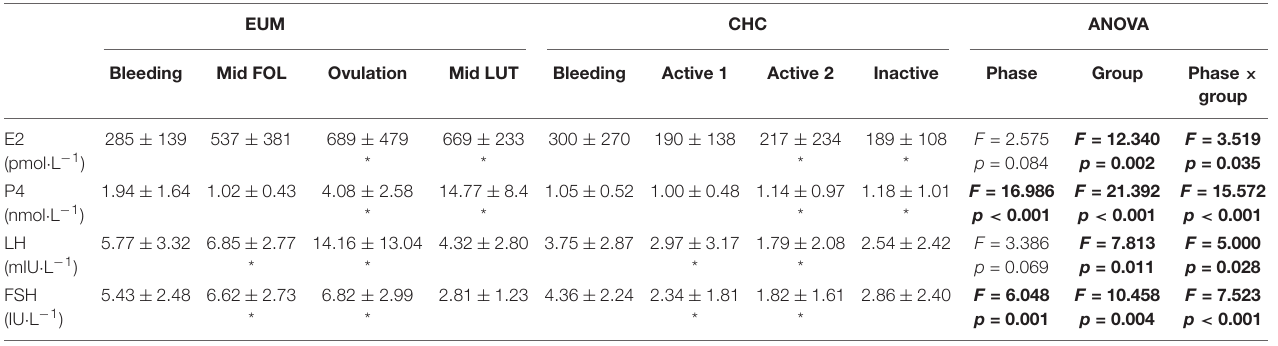
TABLE 3 | Serum concentrations of estradiol (E2), progesterone (P4), luteinizing hormone (LH), and follicle-stimulating hormone (FSH) across the four cycle phases for the non-hormonal contraceptive (EUM) and hormonal contraceptive (CHC) groups. EUM CHC ANOVA Bleeding Mid